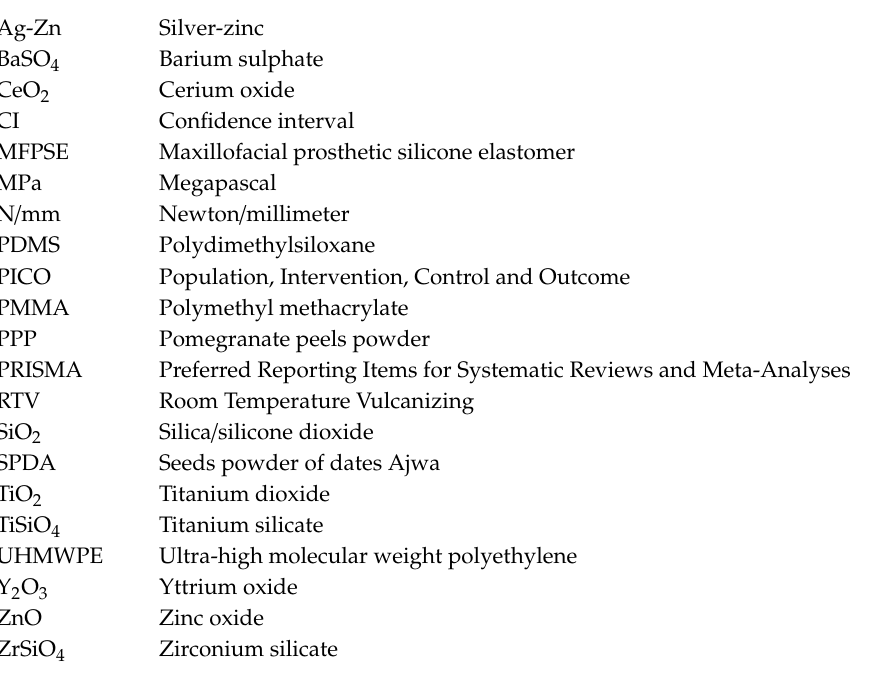
Table S1: Subgroup analysis and forest plot of hardness (Shore A)